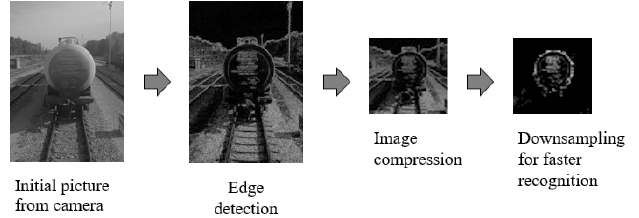
Fig. 11. Training set of wagon